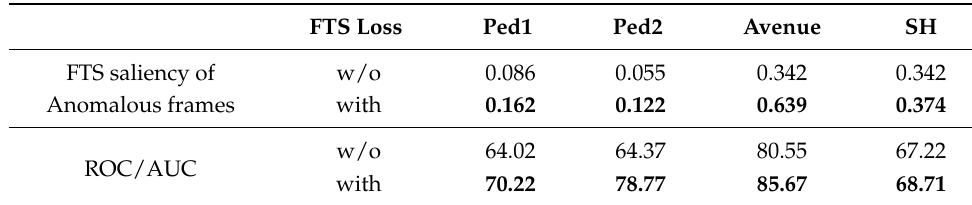
Figure 8. The ROC/AUC curves of the FTS detectors trained with and without utilizing the FTS loss on multiple datasets. The red curve is represents the detector trained with FTS loss. The blue curve represents the detector trained without FTS loss. ( a ) The ROC/AUC curves on Avenue dataset. ( b ) The ROC/AUC curves on Ped2 dataset. The dashed blue line represent the ROC curve of a completely random classifier. Table 3. Frame-level FTS saliency and ROC/AUCs of the FTS detectors on multiple datasets. The bold font represent FTS saliency of anomalous frames and ROC/AUC performances utilizing the FTS loss.